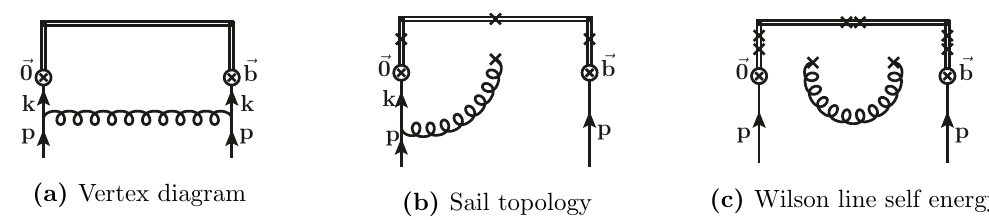
Figure 3. One-loop diagrams contributing to the quasi TMD beam function (with the mirrored sail diagram not shown). The double line represents straight Wilson line segments and the (cid:10) are the quark (cid:12)elds. The crosses in (b) and (c) denote the set of locations for attaching the gluon that have to be